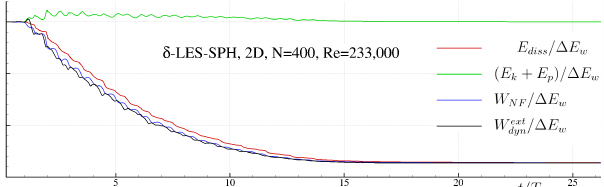
Figure 11. Test with water: time histories of the dissipated energy E diss , mechanical energy ( E k + E p ) , work completed by the non-inertial forces W NF and work completed by the tank wall to slosh the fluid W ext . dyn